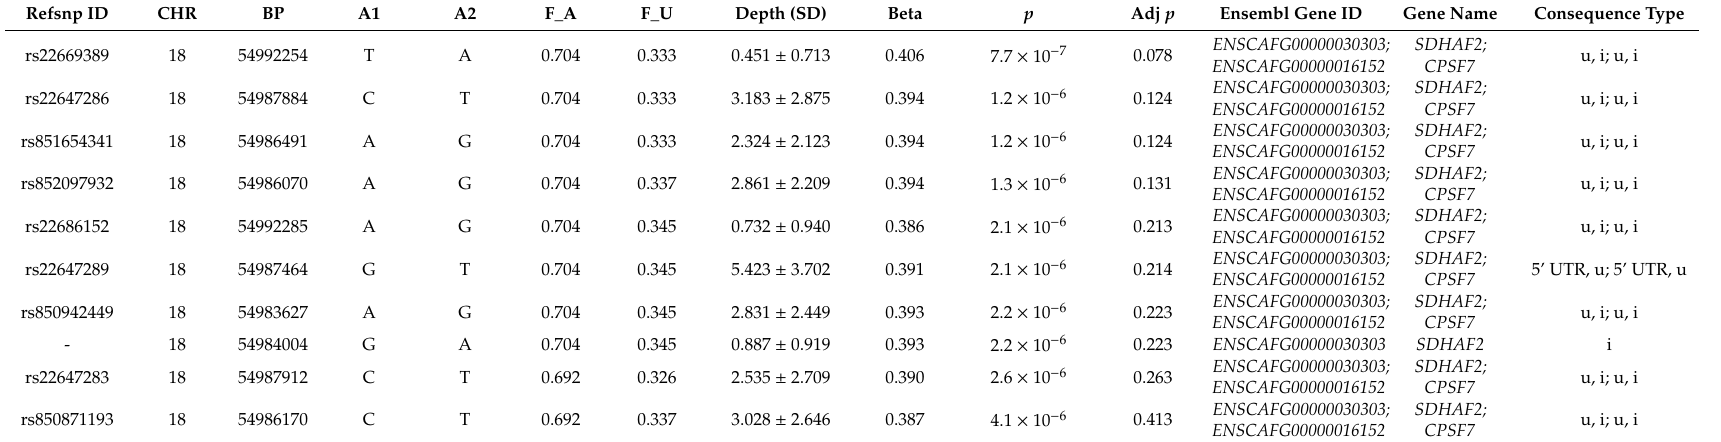
Table 1. Details of the top 10 single nucleotide polymorphisms (SNPs) detected in the genome-wide association study (GWAS). p -values were adjusted using the Bonferroni method, accounting for 101,740 independent